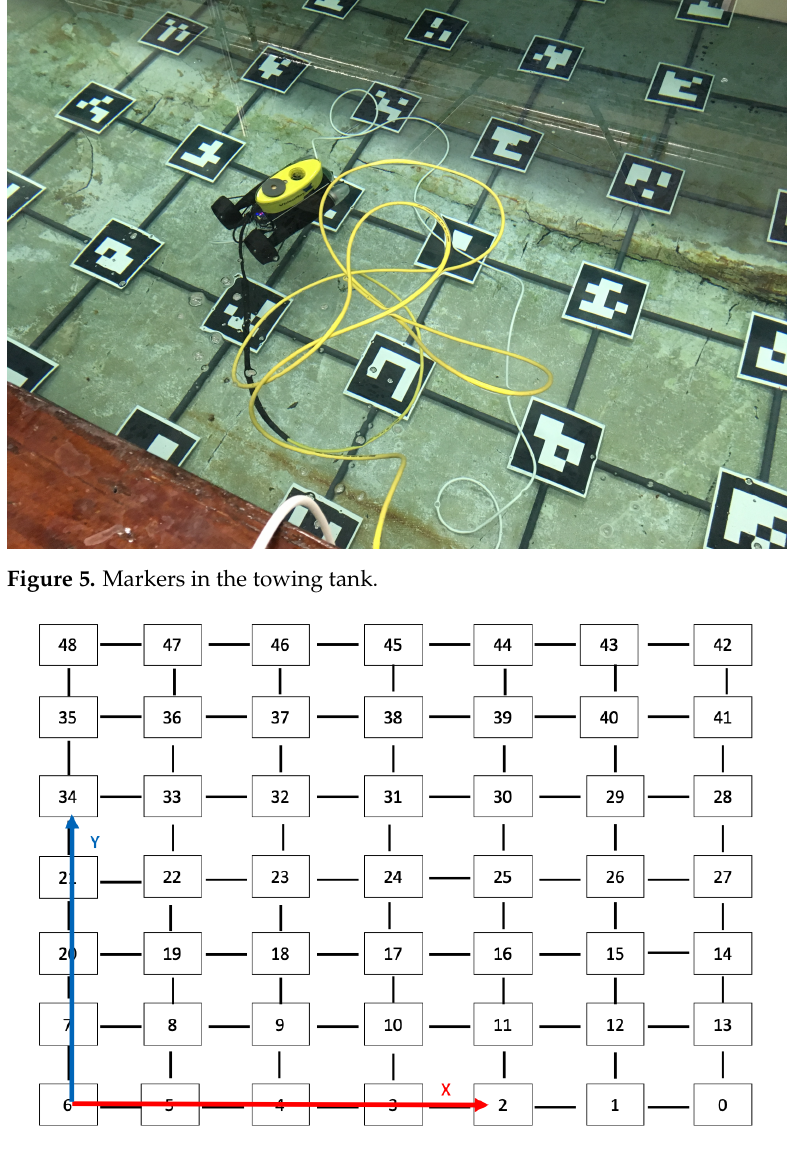
Figure 6. Reference of the